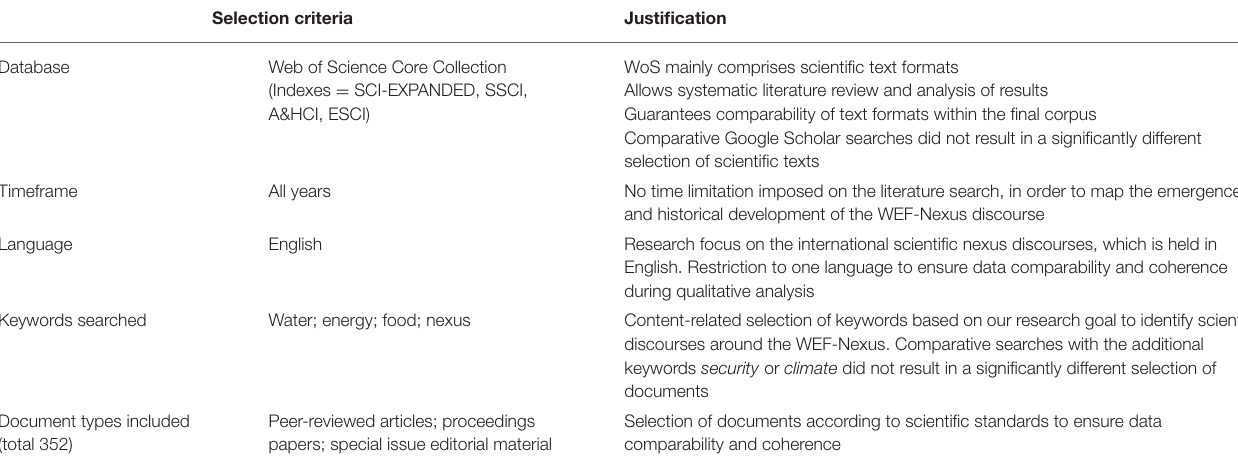
TABLE 1 | Criteria guiding the selection of documents for the overall text corpus. Selection